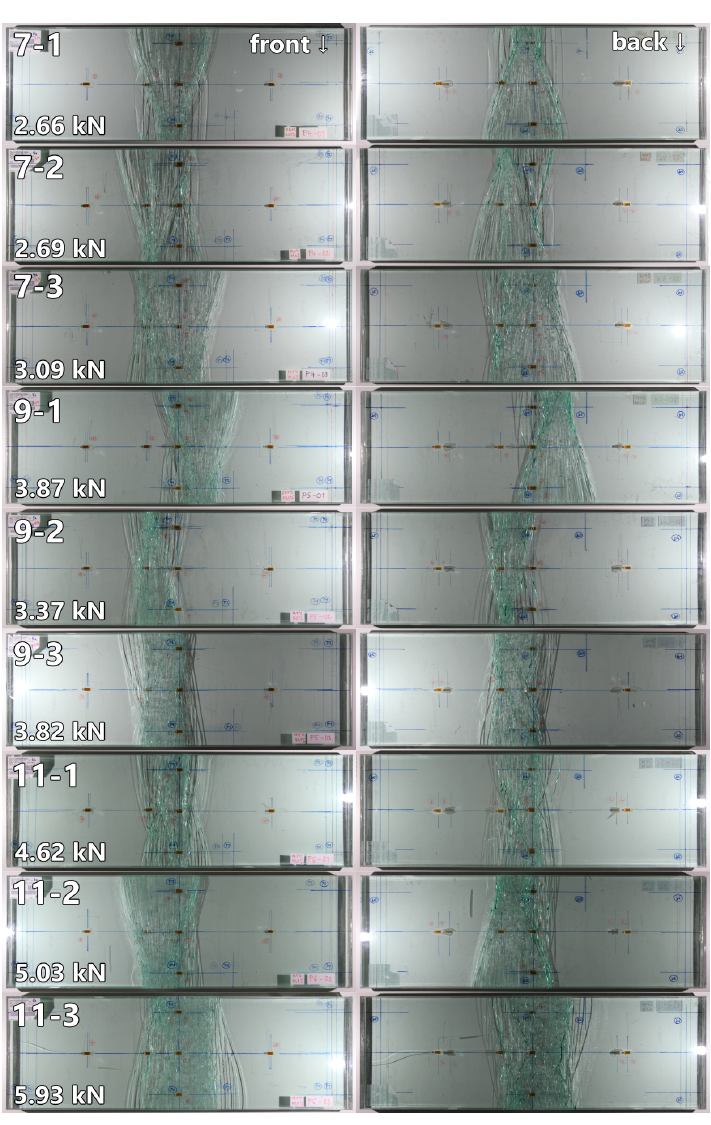
Figure A1. Specimens after quasi-static testing. Force values are peak